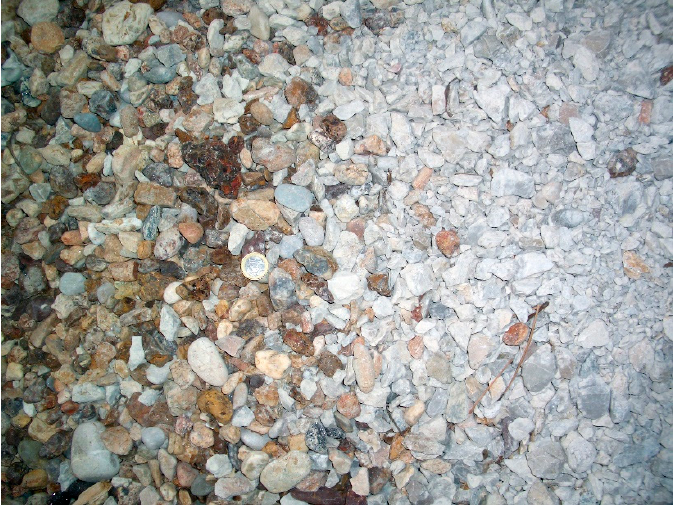
Figure 5. Fill materials used at Cavo: on the left side the iron rich mining waste, on the right side the new carbonate sandstone of the second nourishment. One euro coin for reference at the centre of the photo.